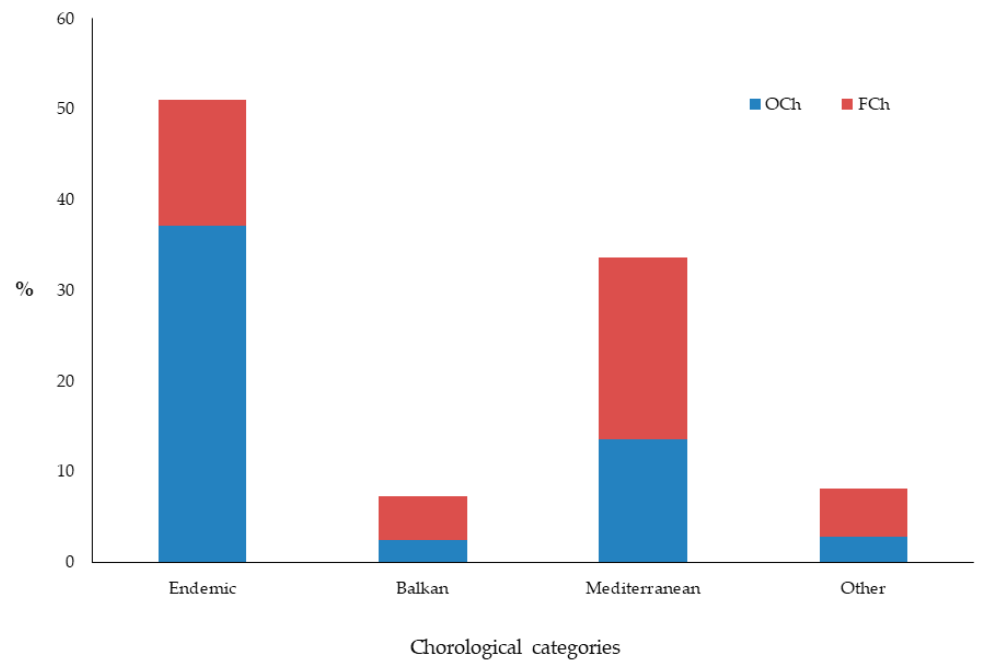
Figure 5. Chorological category proportions for obligate (OCh) and facultative (FCh) chasmophytes.